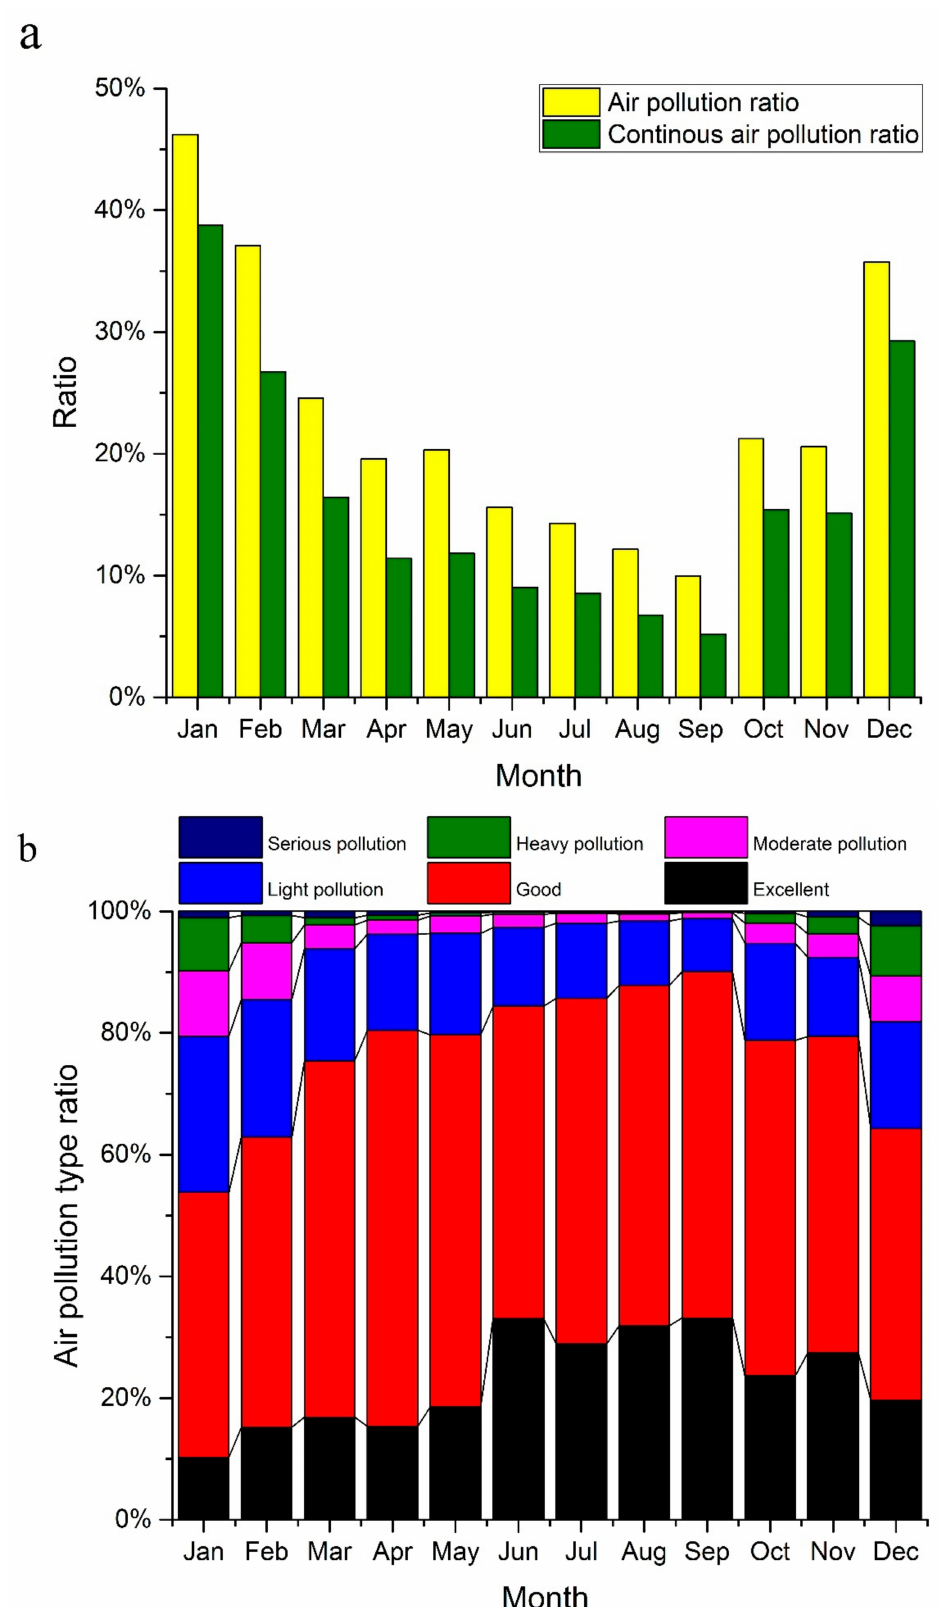
Figure 4. Temporal variations of air pollution in China. ( a ) air pollution ratio and continuous air pollution ratio by month ( b ) air pollution type ratio by